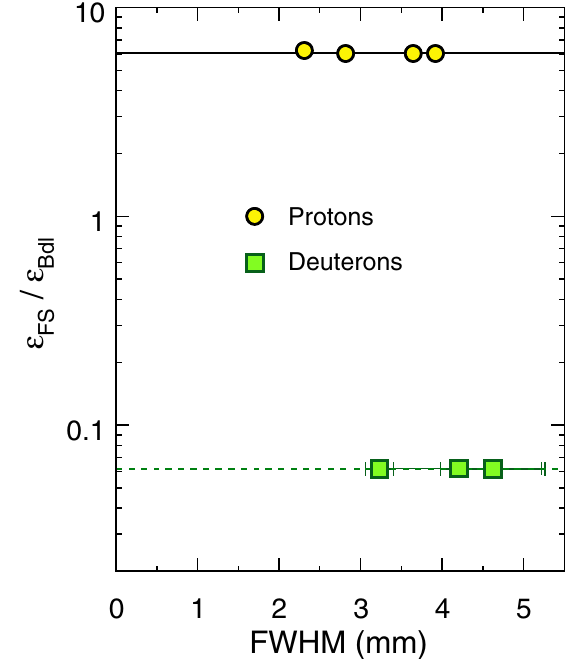
FIG. 5. (Color) Ratio of E to E is plotted vs the vertical FS Bdl is the resonance strength obtained by beam size (FWHM). E FS is obtained fitting the (cid:1) t curve for each data point to Eq. (3); E Bdl using each data point’s R Bdl in Eq. (5). Fits to horizontal straight lines give resonance strength ratios of 6 : 07 (cid:6) 0 : 04 for values were protons and 0 : 0618 (cid:6) 0 : 0002 for deuterons. The (cid:1) y 3.525 for protons and 3.60 for